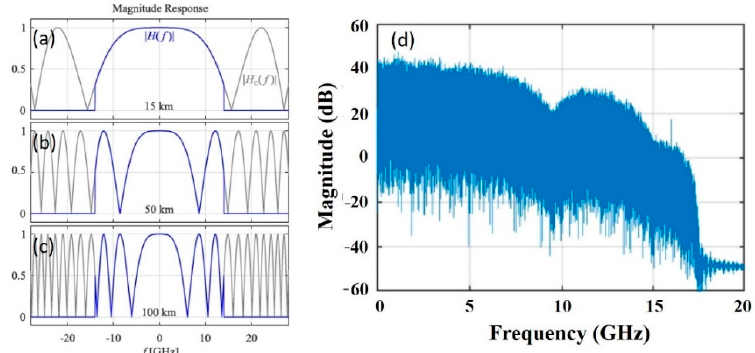
Figure 6. Magnitude responses of a 28 Gbaud PAM4 system after ( a ) 15 km; ( b ) 50 km; ( c ) 100 km in simulation (reprinted from [65] with permission from IEEE). ( d ) Frequency spectrum of the detected 25 Gbaud PAM4 signal over 50 km SSMF transmission (reprinted from [66] with permission from